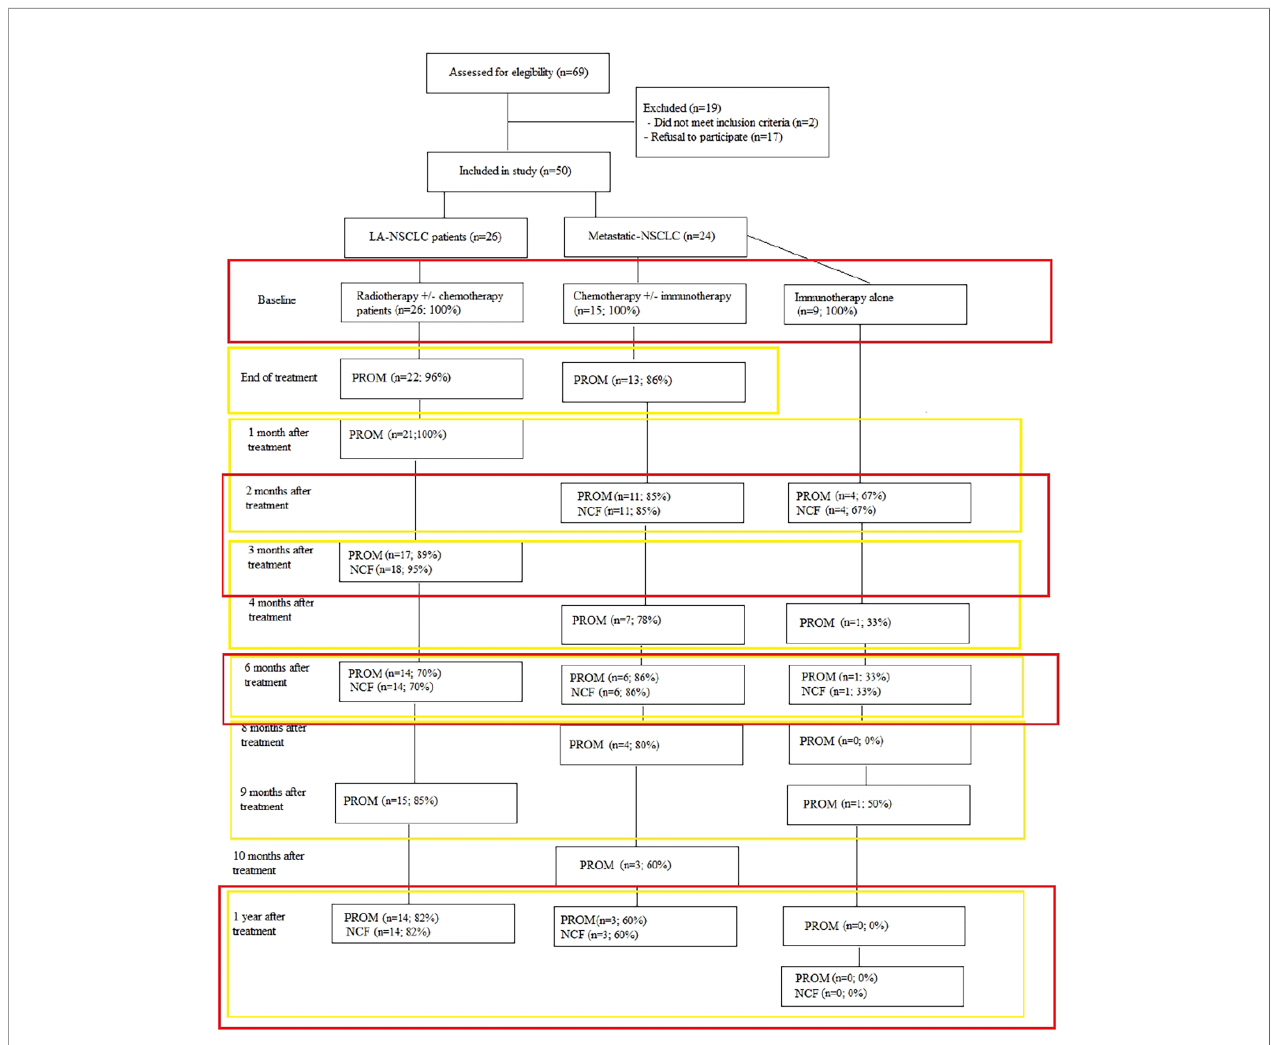
FIGURE 1 | Overview of data collected per time point and data handling strategy. Red rectangles denote the data that were analysed together for the changes compared to baseline, the yellow rectangles show the data analysed together in the mixed model